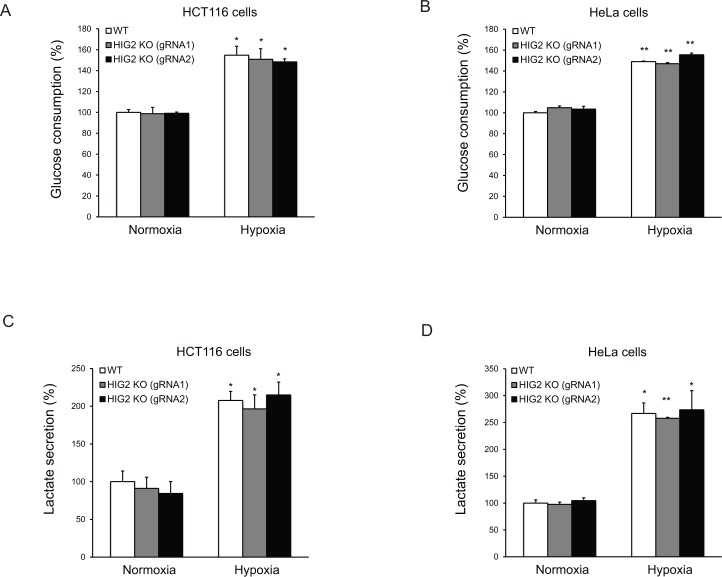
The effects of lipolysis on glucose metabolism.HCT116 or HeLa clone cells were cultured under normoxia or hypoxia for 24 hr and then media were collected to measure glucose and lactate levels. Glucose consumption and lactate secretion were calculated based on 24 hr incubation normalized to cellular protein contents. n = 2 biologically independent experiments. *p<0.05, **p<0.01 vs. Normoxia. All data represent three independent experiments. Graphs represent mean ± SD, and were compared by two-tailed unpaired Student t-test.